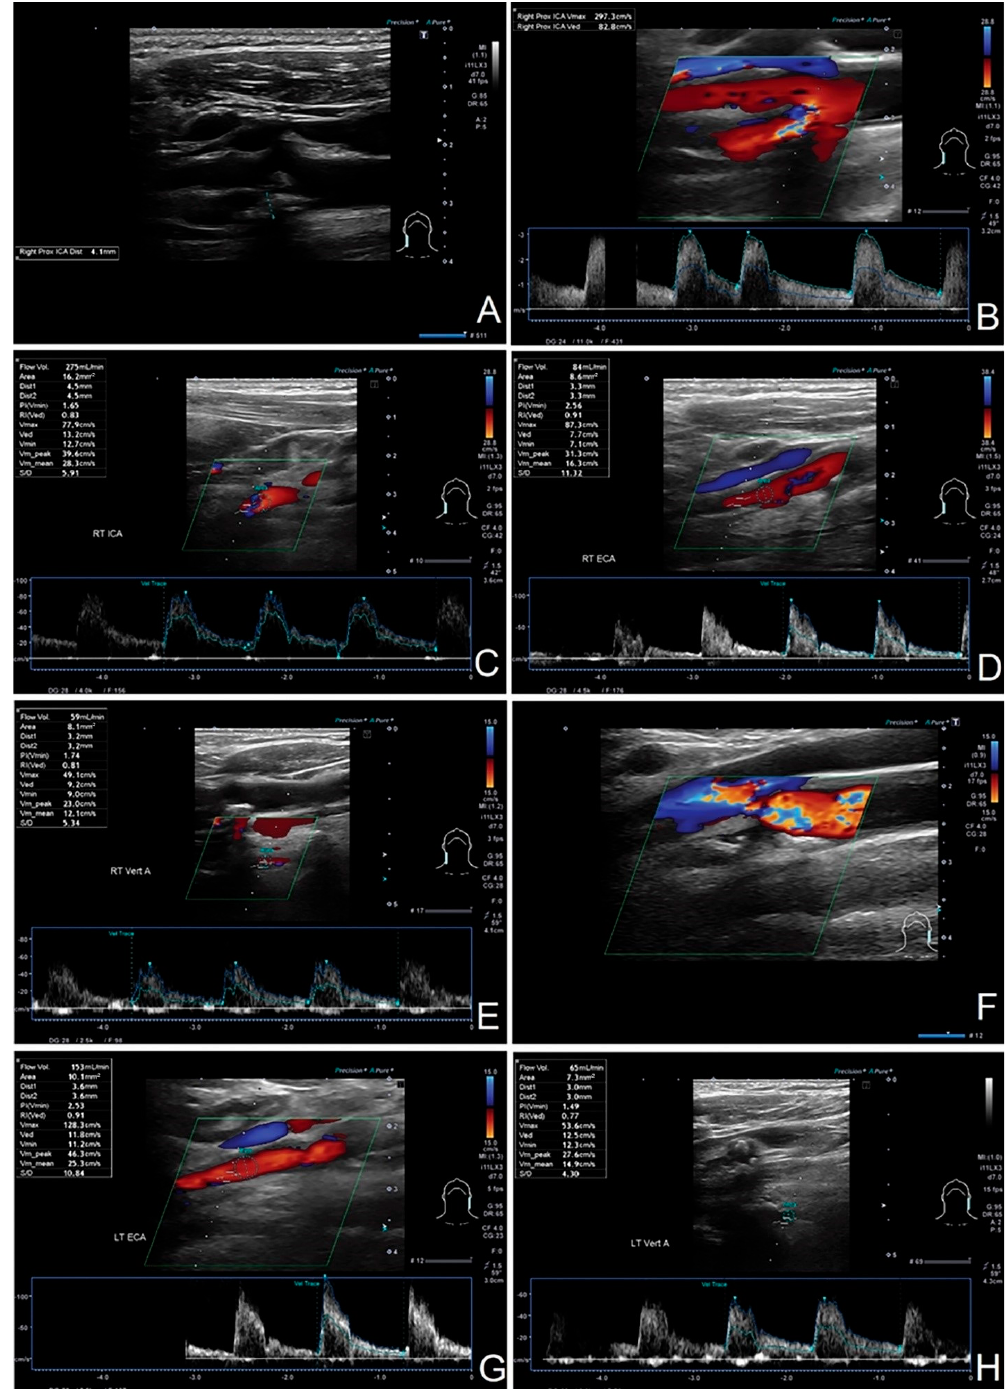
Figure 11. Patient with left-sided ICA occlusion, 70% right-sided ICA stenosis, and no significant flow compensation in other extracranial arteries. ( A , B ) About 70% RICA stenosis with flow velocity of 2.97/0.83 m/s; ( C ) distal part of the ICA with flow volume of 275 mL/min; ( D ) flow volume in RECA of 84 mL/min—no compensation; ( E ) flow volume in RVA of 59 mL/min—no compensation; ( F ) left-sided LICA occlusion; ( G ) slightly compensatory increased flow in LECA with flow volume of 153 mL/min; ( H ) flow volume in LVA of 65 mL/min—no compensation. Due to the lack of volumetric flow compensation, early elective surgical treatment should be